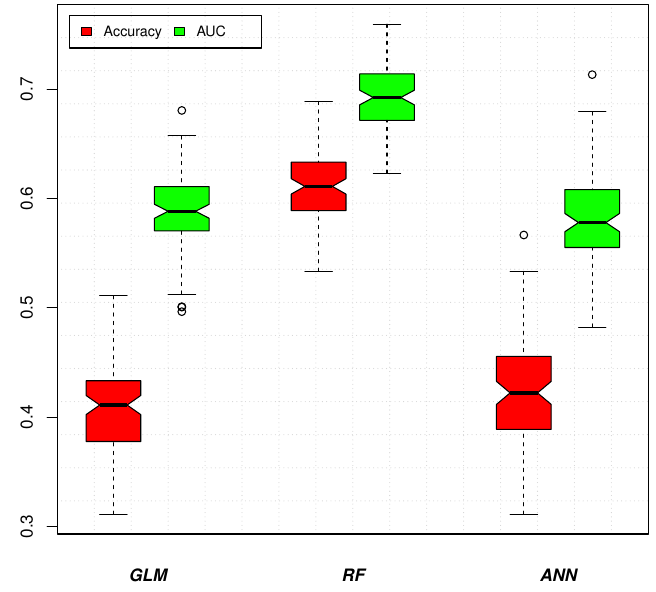
Figure 3. Accuracy and AUC for the three implemented models: GLM, RF and ANN. Each distribu- tion was computed through a 5-fold cross validation procedure repeated 100 times. Empty bullets represent the outliers of distributions.